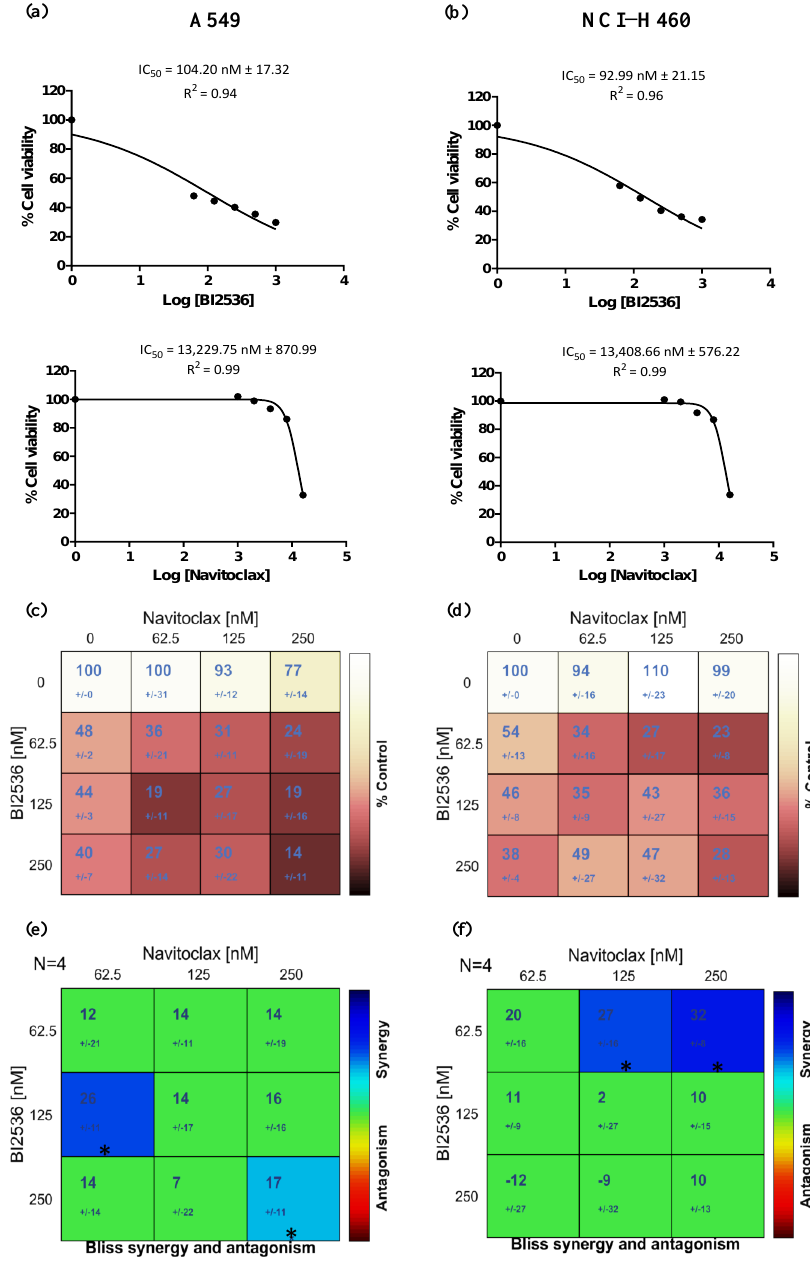
Figure 2. BI2536/Navitoclax combination exacerbates cytotoxicity of lung cancer cells. Dose − response curve of BI2536 and Navitoclax in A549 ( a ) and NCI − H460 ( b ) cell lines. Cell viability (%) of mono or dual − drug combinations after 48 h of treatment in A549 ( c ) and NCI − H460 ( d ) cells, from four independent experiments, as determined by MTT assay. Synergy scores calculated by the Bliss model of Combenefit software with statistical relevance of * p < 0.05 in A549 ( e ) and NCI-H460 ( f ).